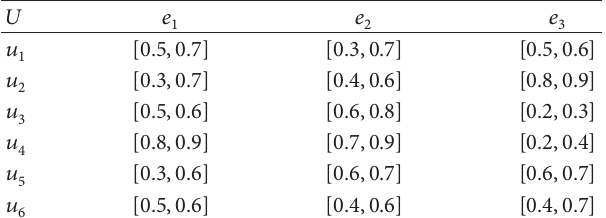
Table 2: Tabular representation of the IVF soft set B 1